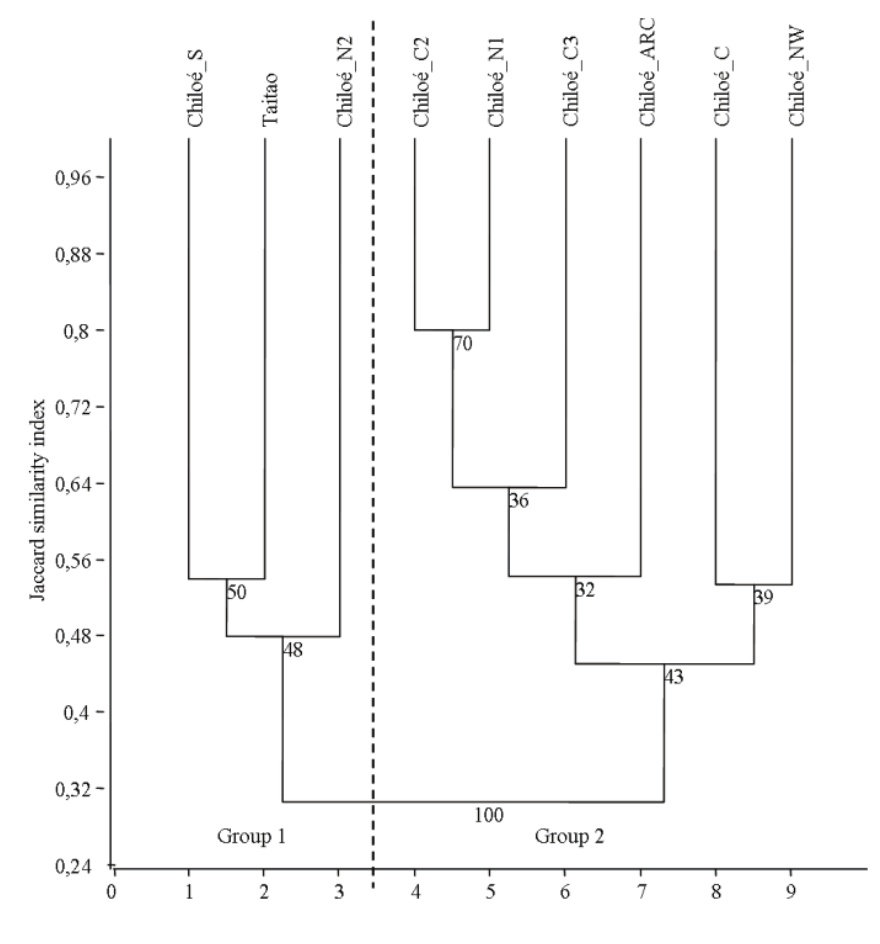
Figure 2. Cluster analysis based on the floristic composition of tree species in different studies in the insular region of North Patagonia. Numbers close to nodes represent the bootstrap support. The dotted line represents division into 2 groups. Group